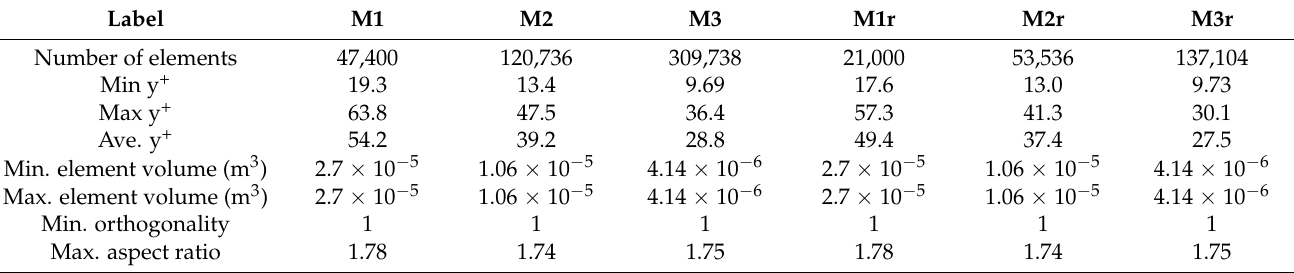
Table 2. Information about analyzed computational meshes: M1—coarse mesh, full domain; M2—medium mesh, full domain; M3—fine mesh, full domain; M1r—coarse mesh, reduced